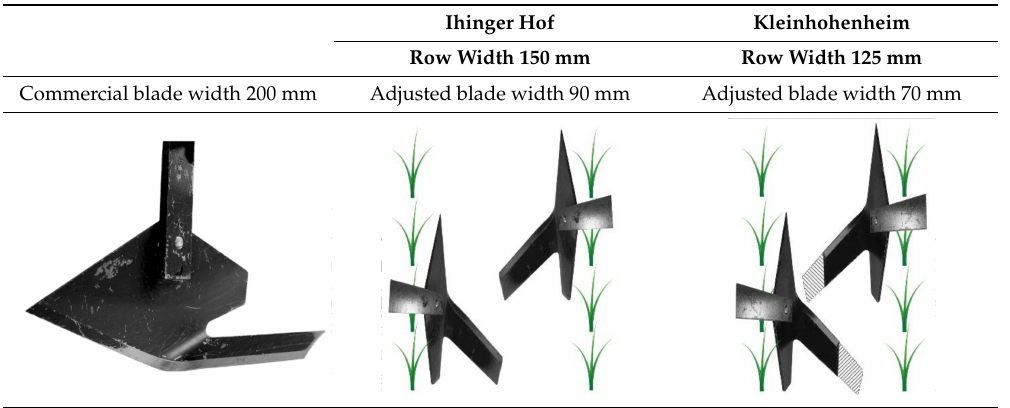
Table 3. Side view of the commercial down-cut side knife and top view of the down-cut side knives adjusted to the narrow row widths of 150 and 125 mm at Ihinger Hof and Kleinhohenheim, respectively. Hatched lines (here only shown for the 125 mm row width) indicate the blade length that was cut off from the commercial knife blade to fit the side knives between the cereal rows. The plants left and right of the side knives symbolize cereal